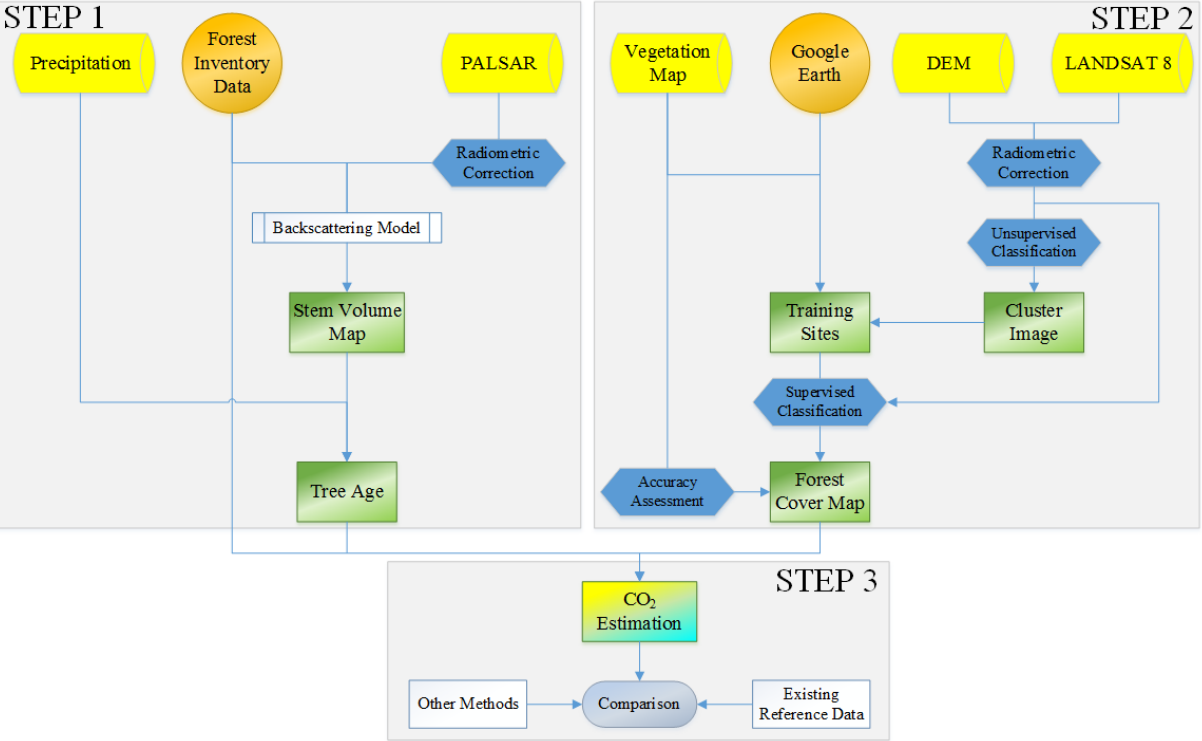
Figure 2. Overall flowchart of the